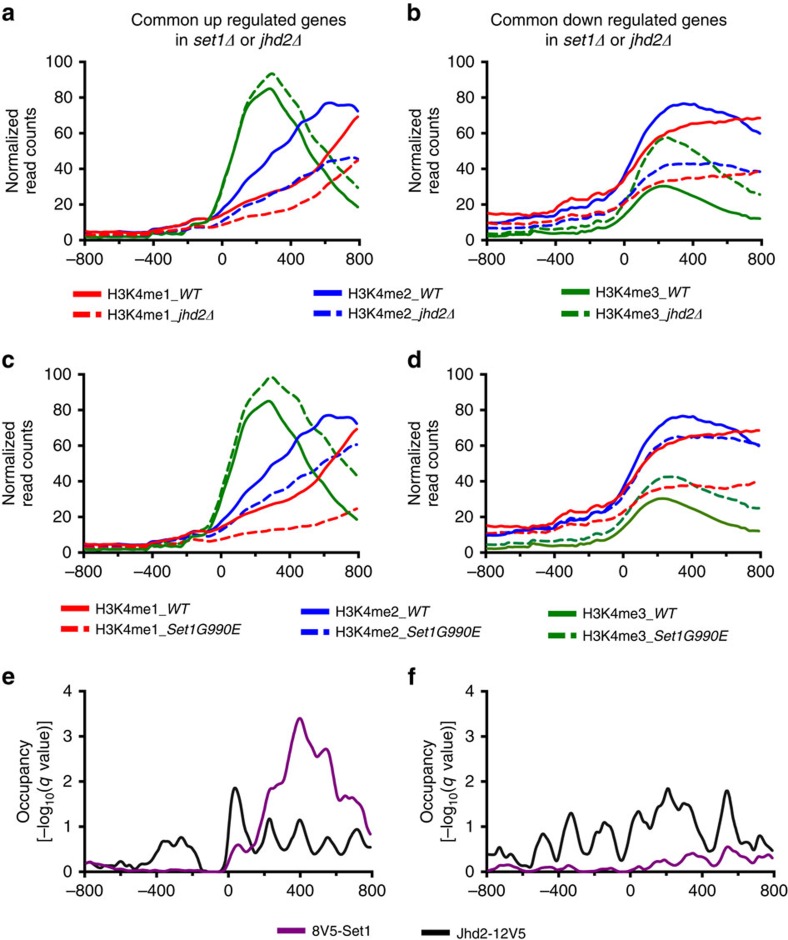
Set1 and Jhd2 localize to their shared target genes and regulate H3K4 methylation.(a,b) Normalized-read counts profiles for H3K4 monomethyl (me1), dimethyl (me2) and trimethyl (me3) marks across 800 bp region upstream (−) or downstream (+) of the TSSs (0) at target genes co-repressed (a) or co-activated (b) by Set1 and Jhd2 in WT and jhd2Δ null mutant. (c,d) Normalized-read counts profiles for H3K4me1, H3K4me2 and H4K4me3 marks across regions, as described for (a,b), at genes co-repressed (c) or co-activated (d) by Set1 and Jhd2 in WT and Set1-G990E gain-of-function or hyperactive mutant. (e,f) Statistical enrichment (qpois) profiles for 8V5-tagged Set1 or 12V5-tagged Jhd2 occupancies across 800 bp region upstream (−) or downstream (+) of the TSSs (0) at the Set1 and Jhd2 co-repressed (e) or co-activated (f) target genes.